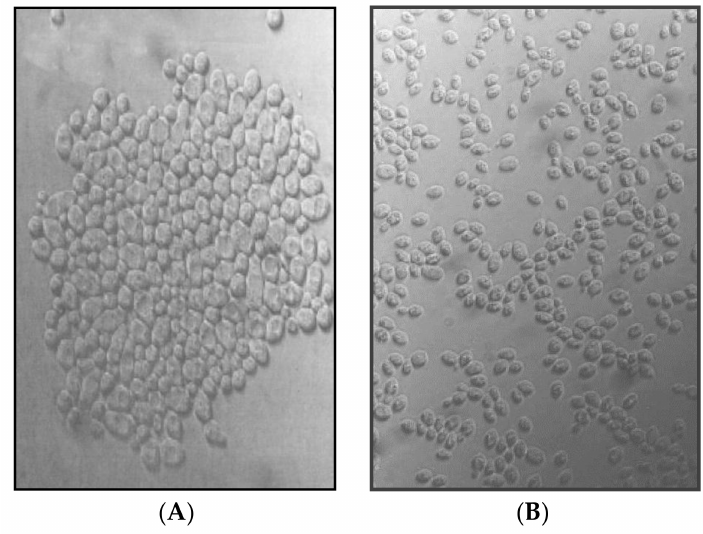
Figure 4. Flocculation characteristics of Saccharomyces cerevisiae strains. ( A ) Flocculent culture; ( B ) non-flocculent culture [10].